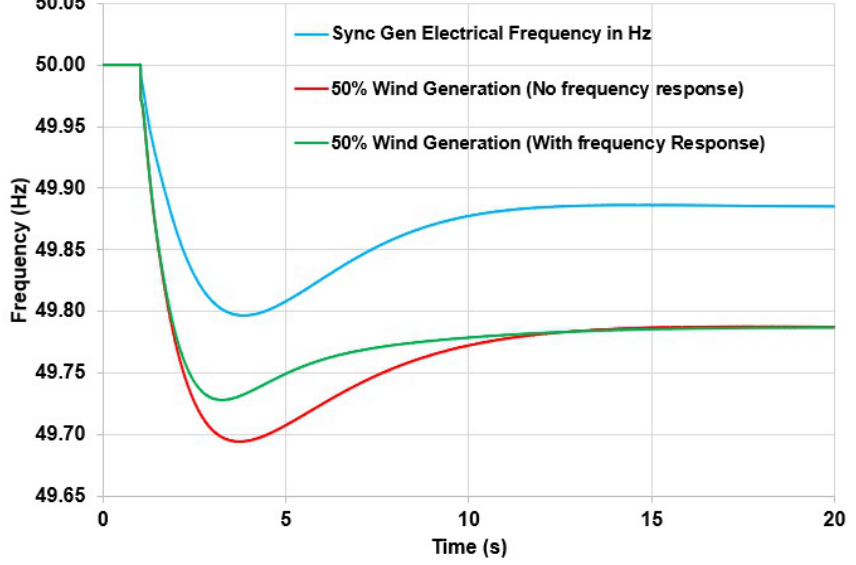
Figure 23. System frequency response with wind